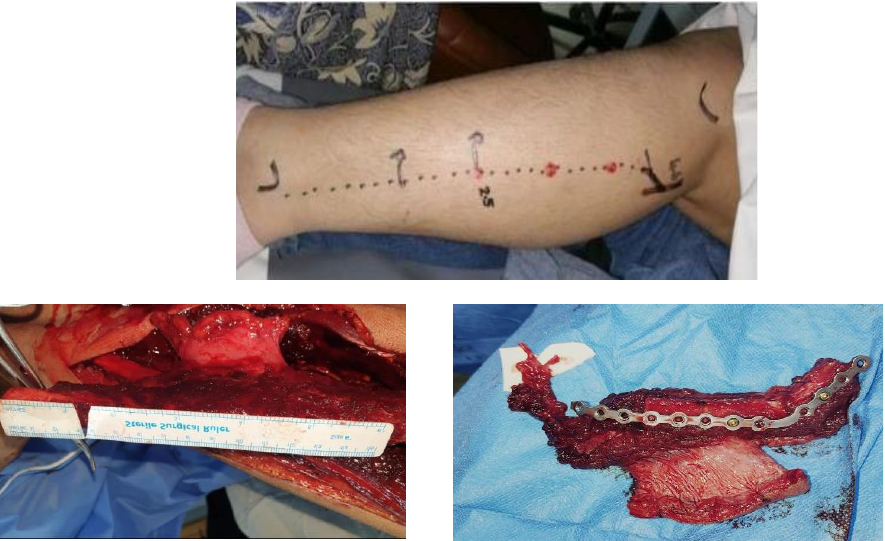
Figure 2. The landmarks and skin markings for fibular flap.